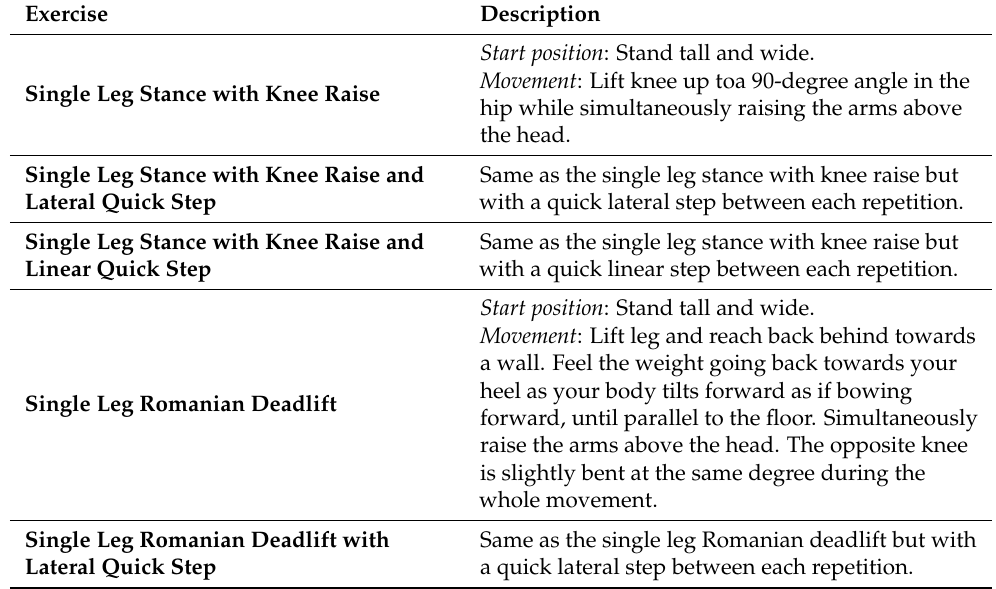
Table 1. Description of exercises used in supplementary body-weight functional stabilization training.